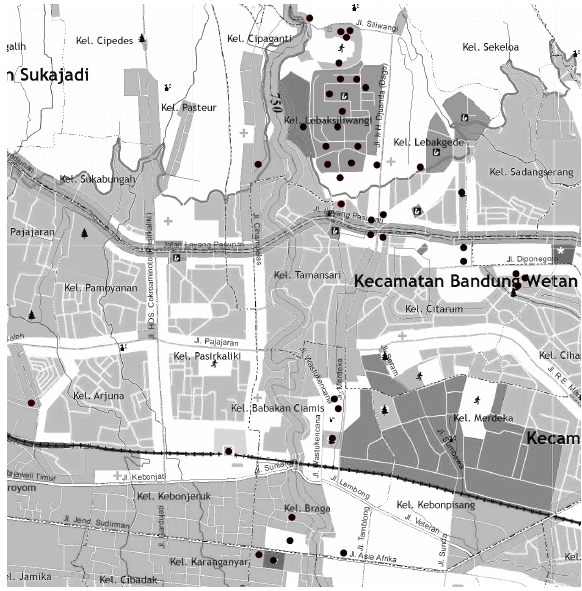
Fig. 2. The location of in situ experiment.